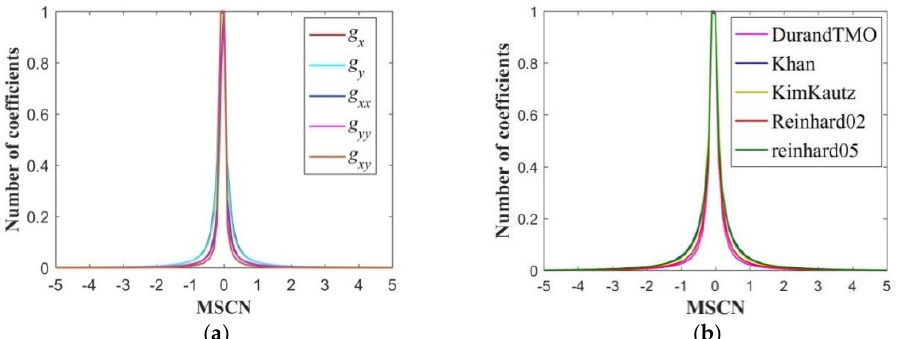
Figure 7. MSCN coefficient distribution curves of derivative maps. ( a ) MSCN coefficient distribution curves of the five derivative maps of the HSOI, which is first compressed by JPEG XT and then processed by DurandTMO, ( b ) MSCN distribution curves of g x of the HSOI which is first compressed by JPEG XT and then processed by the five TMOs.